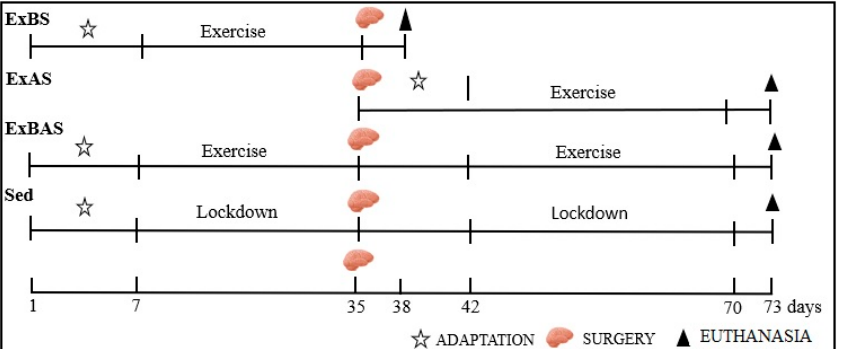
Figure 1. Experimental protocol: exercise before surgery (ExBS); exercise after Surgery (ExAS), exercise before and after surgery (ExBAS), and sedentary (Sed).